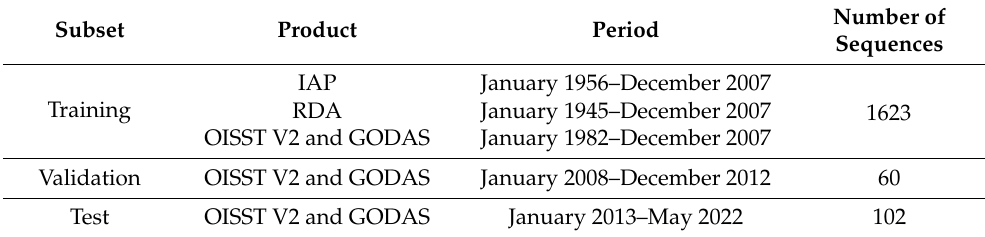
Table 1. Organization of the built